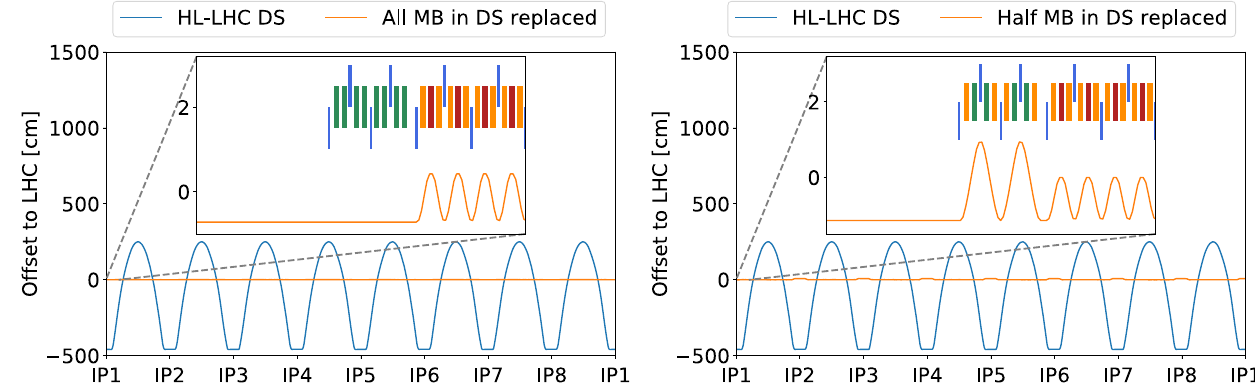
FIG. 9. Left: impact of nonoptimized (blue) and optimized (orange) DS bending radius on geometry offset with respect to LHC for a 1 = 3 option with 7.74 T weak, and 16 T strong dipoles, by replacing all DSs dipoles, together with the lattice shown in Fig. 8 (left) and resulting in a geometry offset of 0 cm and below 1 cm peak-to-peak in the DSs and the arcs, respectively. Right: same, but for the lattice shown in Fig. 8 (right) and resulting in a geometry offset of about 2 cm and below 1 cm peak-to-peak in the DSs and the arcs,